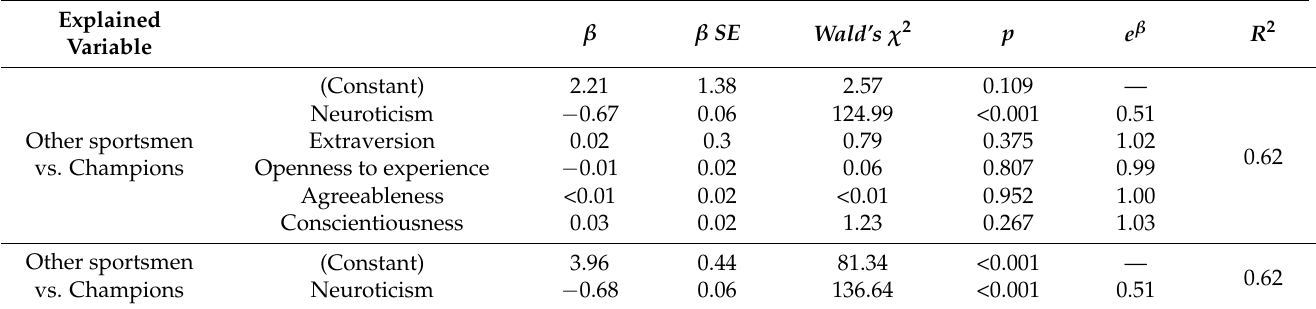
Table 2. Coefficients of the logistic regression model predicting classification to sports champions group or other athletes group, based on personality